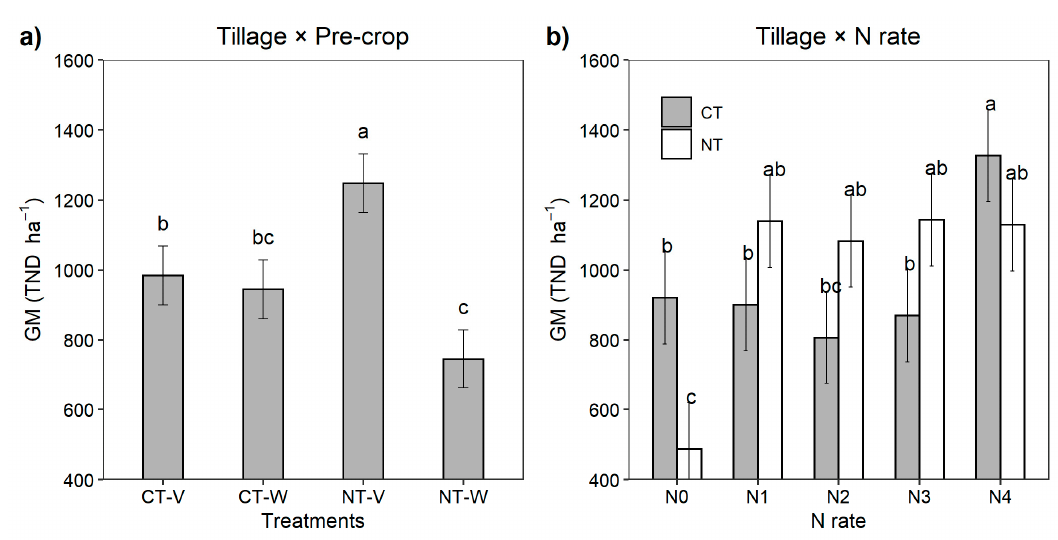
Figure 4. Effect of the two-way interactions of ( a ) Tillage × Pre-crop and ( b ) Tillage × N rate on GM. Data are averages ± standard errors. Different lowercase letters indicate significant differences between all treatments in each item ( p < 0.05). V: Vetch; W: Wheat; CT: conventional tillage; NT: no-tillage.